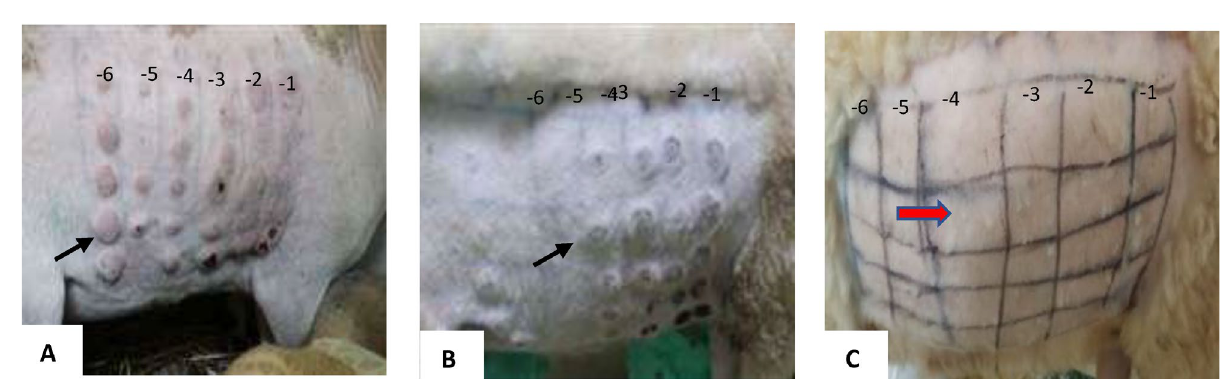
Figure 7. Challenged vaccinated sheep showing hypersensitivity reaction and no local inflammations on site of inoculation with10 −1 to 10 −6 dilutions (left to right) of virulent SPPV. ( A ) Figure of challenged unvaccinated sheep showing local inflammation on site of inoculation. ( B ) Sheep vaccinated with SPPV/RVFV and challenged with SPPV virulent strain ( C ) sheep vaccinated with SPPV alone and challenged with SPPV virulent strain. Black arrow shows inflammation or hypersensitivity reaction on inoculation site. Red arrow shows absence of the hypersensitivity